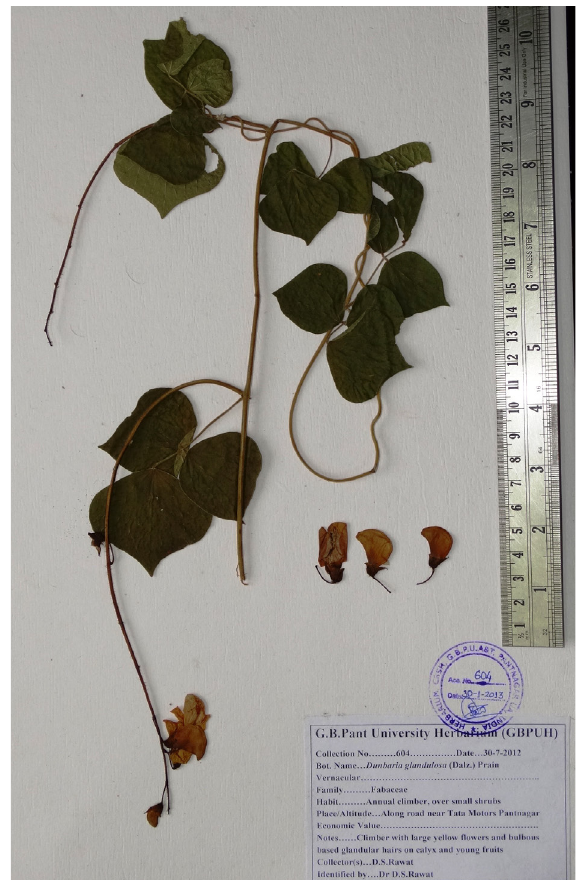
Image 4. Herbarium specimen of Dunbaria glandulosa (Dalz.) Prain